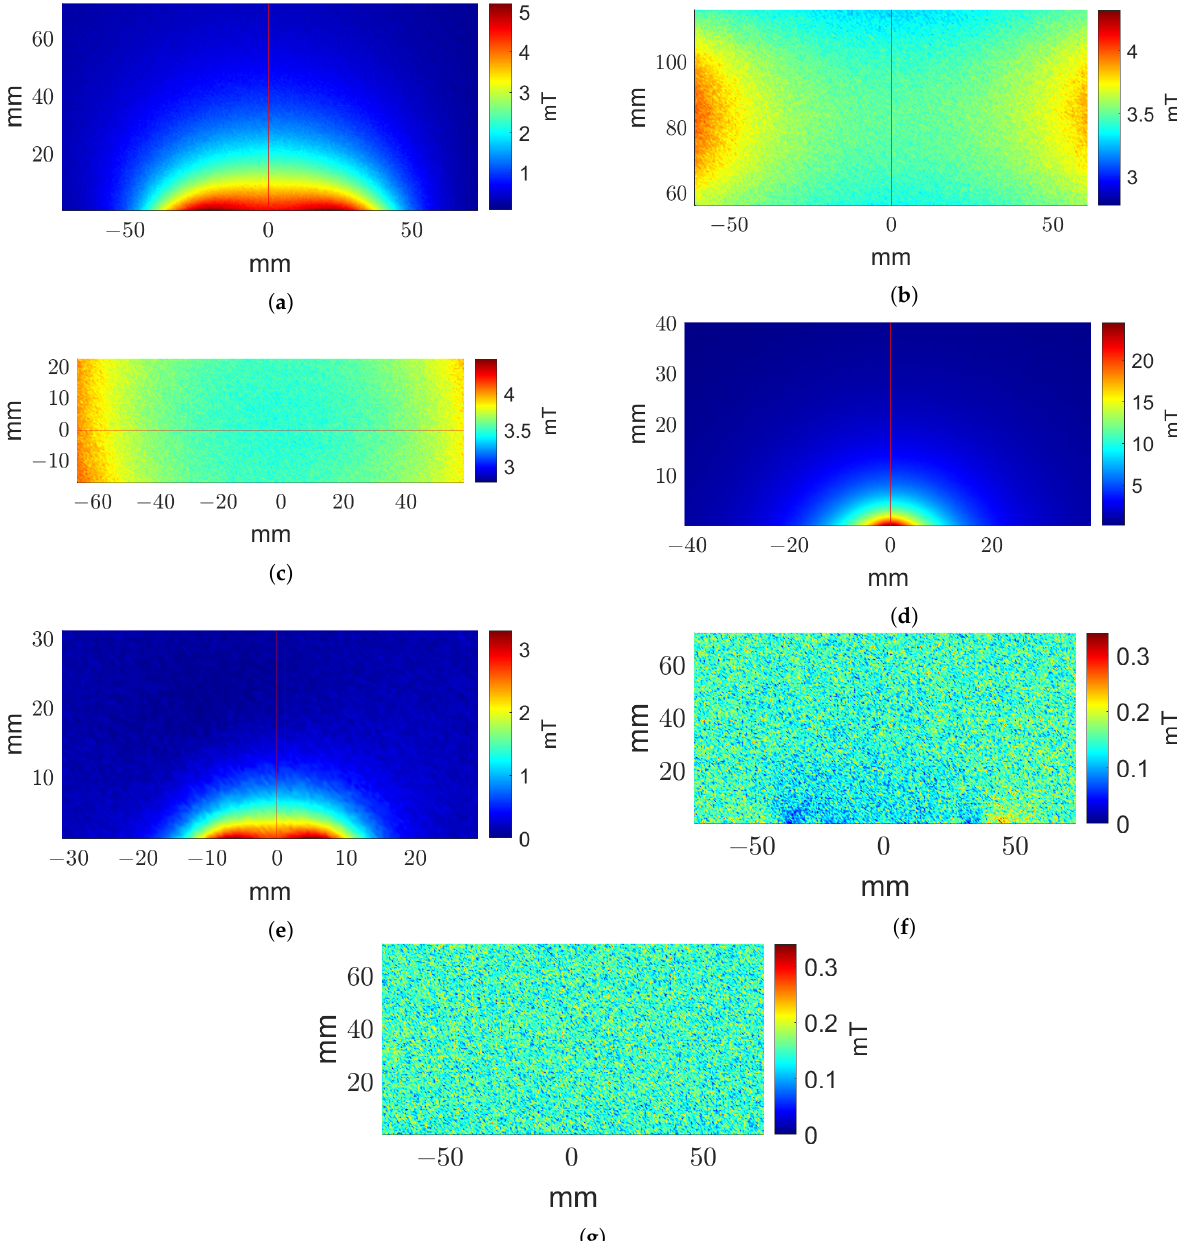
Figure 4. Experimental | B | distributions. ( a ) Air core coil active condition measurements along the central XZ plane. Three-coil system active condition measurements along the central ( b ) XZ and ( c ) XY planes; ( d ) ferromagnetic core coil active condition measurements along the central XZ plane; ( e ) pot core coil active condition measurements along the central XZ plane; ( f ) sham and ( g ) control condition measurements along the central XZ plane for the air core